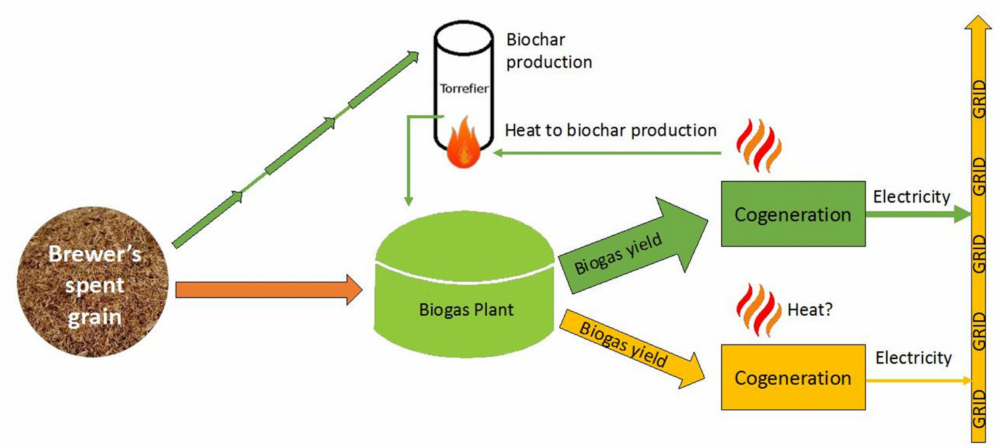
Figure 1. The synergistic combination of brewer’s spent grain (BSG) torrefaction and anaerobic digestion to increase the biogas production